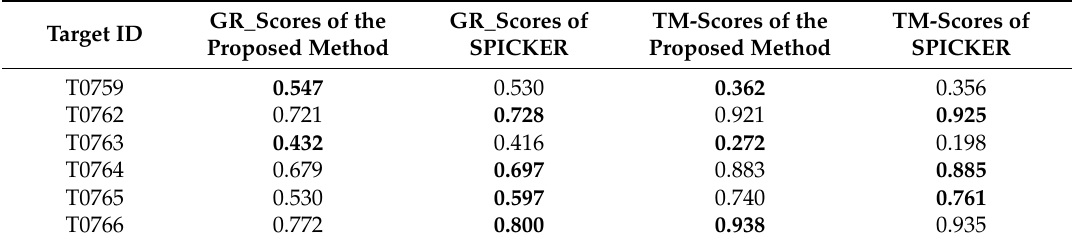
Figure 6. The plot of GR_scores and TM-scores produced by two methods for datasets from CASP11. Detailed results with scores for all the targets are shown in Table 2. Table 2. The Comparison of GR_scores and TM-scores for datasets from CASP11. The bold number indicates the highest GR_score or TM-score for each target.